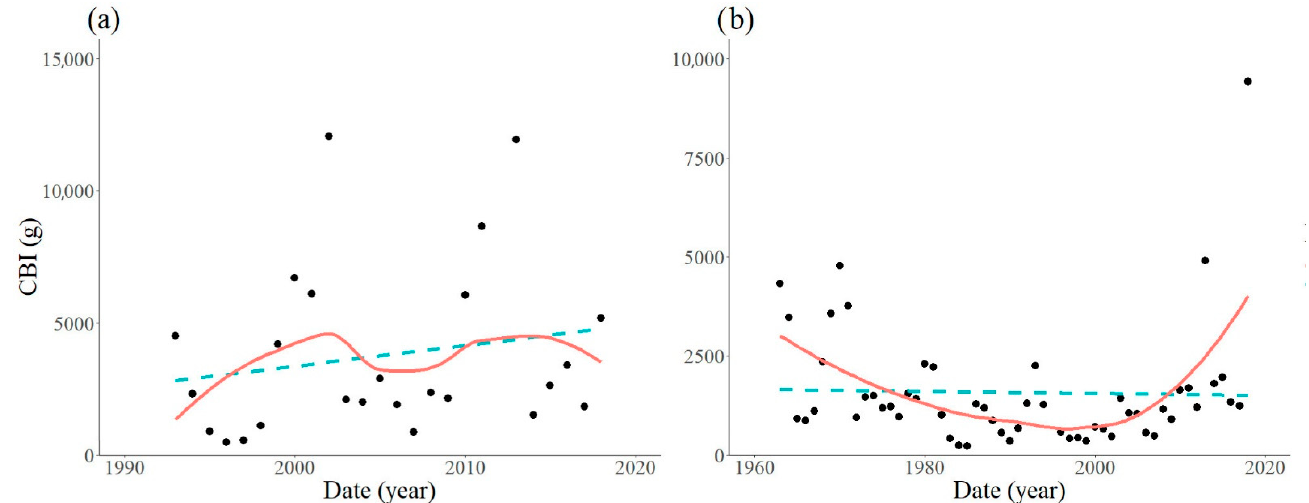
Figure 3. Yearly values and long term trends of the estimated spring caterpillar mass at Kapuvár ( a ), and Várgesztes ( b ). (CBI, Caterpillar Biomass Index; blue dashed line, linear regression; red line, locally weighted regression with α = 0.8).